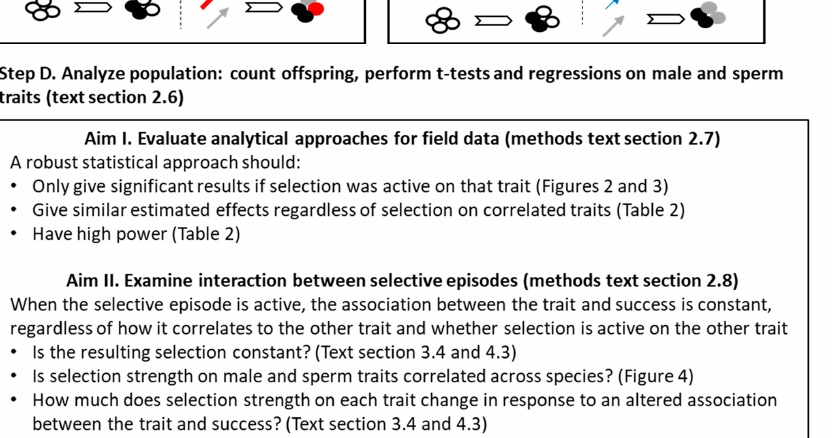
Figure 1. Schematic representation of simulation procedure and explanation of aims. Males (or the eggs they fertilize) are represented by unique colors. The male trait is indicated by a circle of varying size and the sperm trait by an arrow of varying length and width. The circle and arrow are dashed when they do not indicate specific individuals. Populations had either only pre-copulatory selection active (Steps B-2 and C-1), only post-copulatory selection active (Steps B-1 and C-2), or both episodes active (Steps B-2 and C-2). For each of these combinations, varying correlations between the male trait and sperm trait were tested. The female was assigned a number of extra-pair copulations (EPCs), E , by drawing from a Poisson distribution with species-specific mean m; E did (B-2) or did not (B-1) depend on the within-pair male’s male trait. From the available extra-pair males (four shown here, for illustration), E actual copulation partners were drawn, randomly (B-1) or depending on the extra-pair male’s male trait (B-2). The probability that each egg was fertilized by extra-pair sperm was calculated, either depending only on E and a species-specific term s (C-1, Equation (1)), or depending on E , s , and the relative sperm quality of the within-pair male and extra-pair copulation partners (C-2, Equation (2)). For extra-pair eggs, the sire was assigned from among the extra-pair copulation partners either randomly (C-1) or depending on their sperm trait (C-2). Illustrations of available sperm for population C-1 are from step B-1, and for C-2 from B-2. Aims are explained, with reference to methods sections and results text, figures and/or